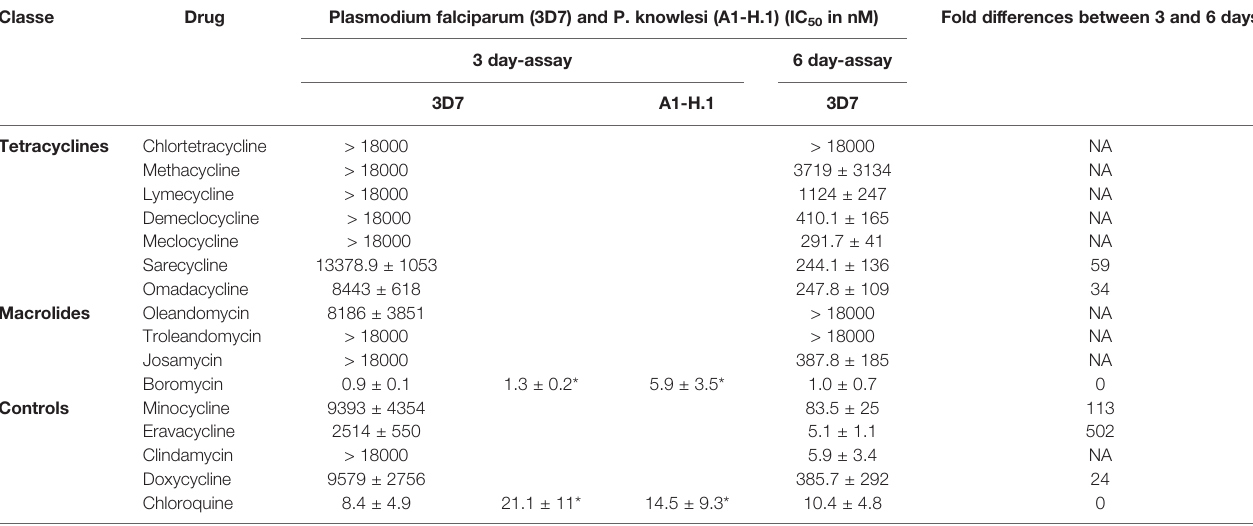
TABLE 1 | Activity of antibiotics against P. falciparum strain 3D7 after 3 and 6 days of incubation and P. knowlesi strain A1-H.1 after 3 days.